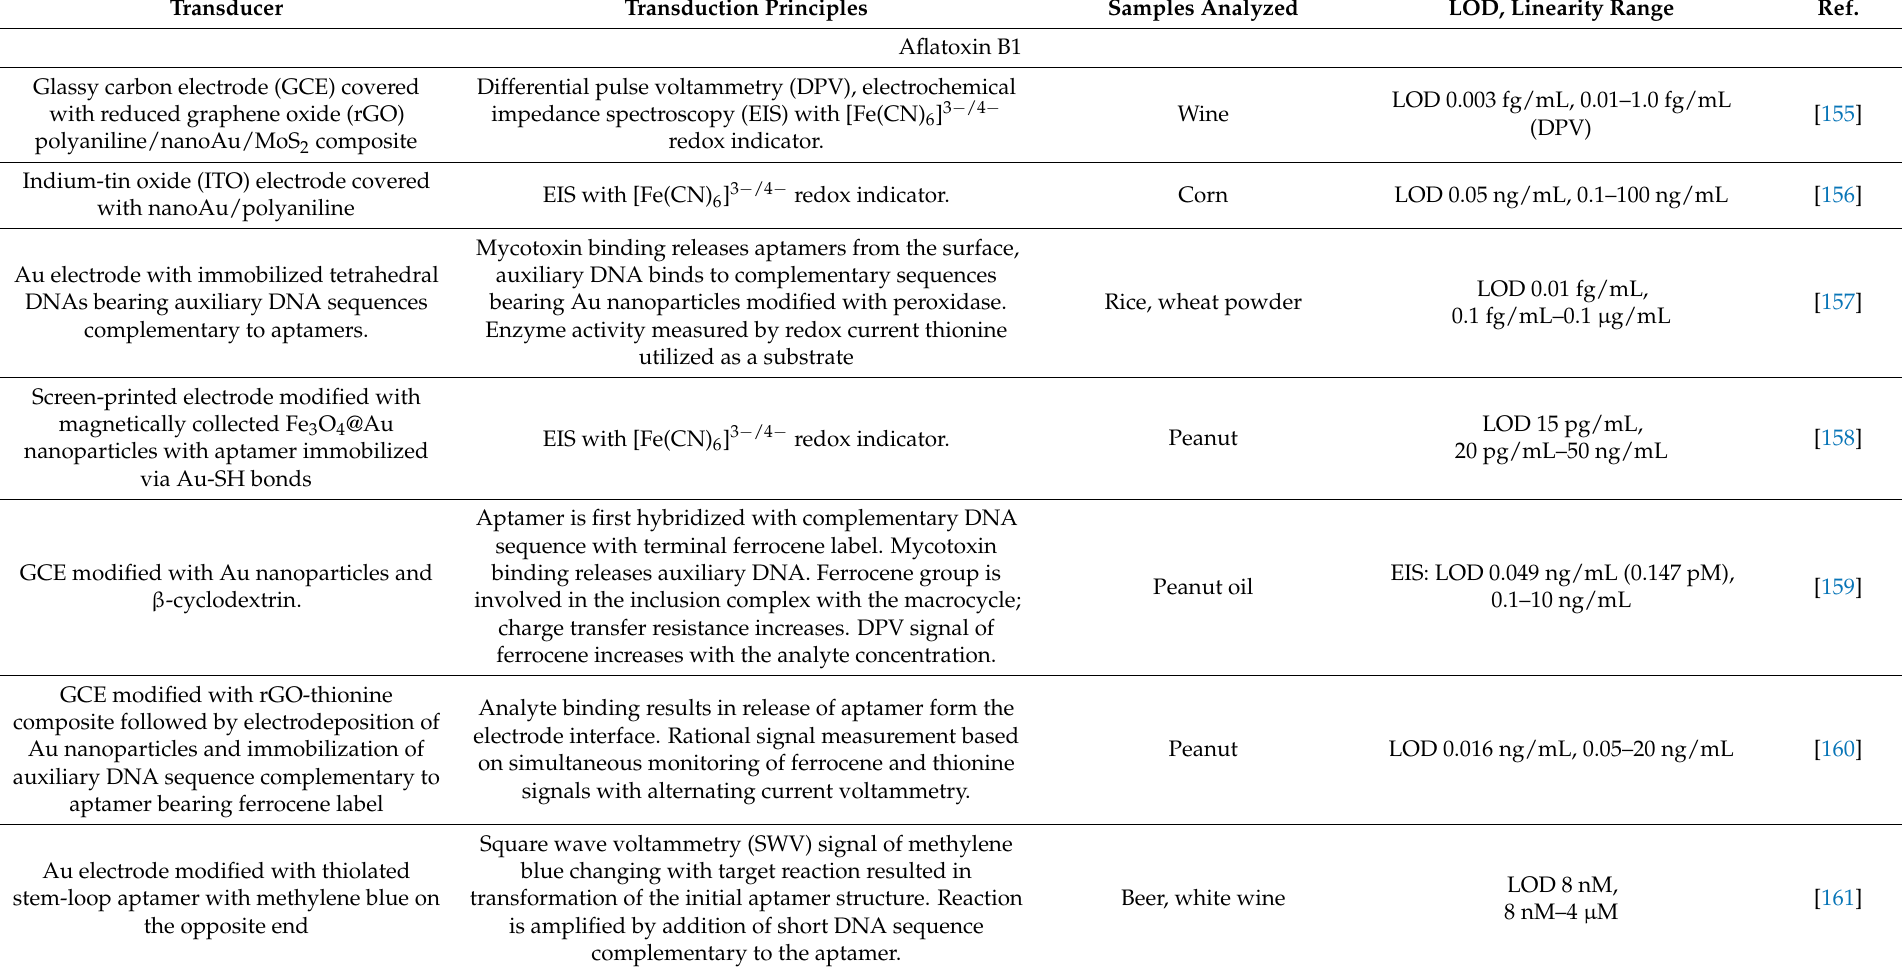
Table 4. Electrochemical aptasensors for mycotoxin determination